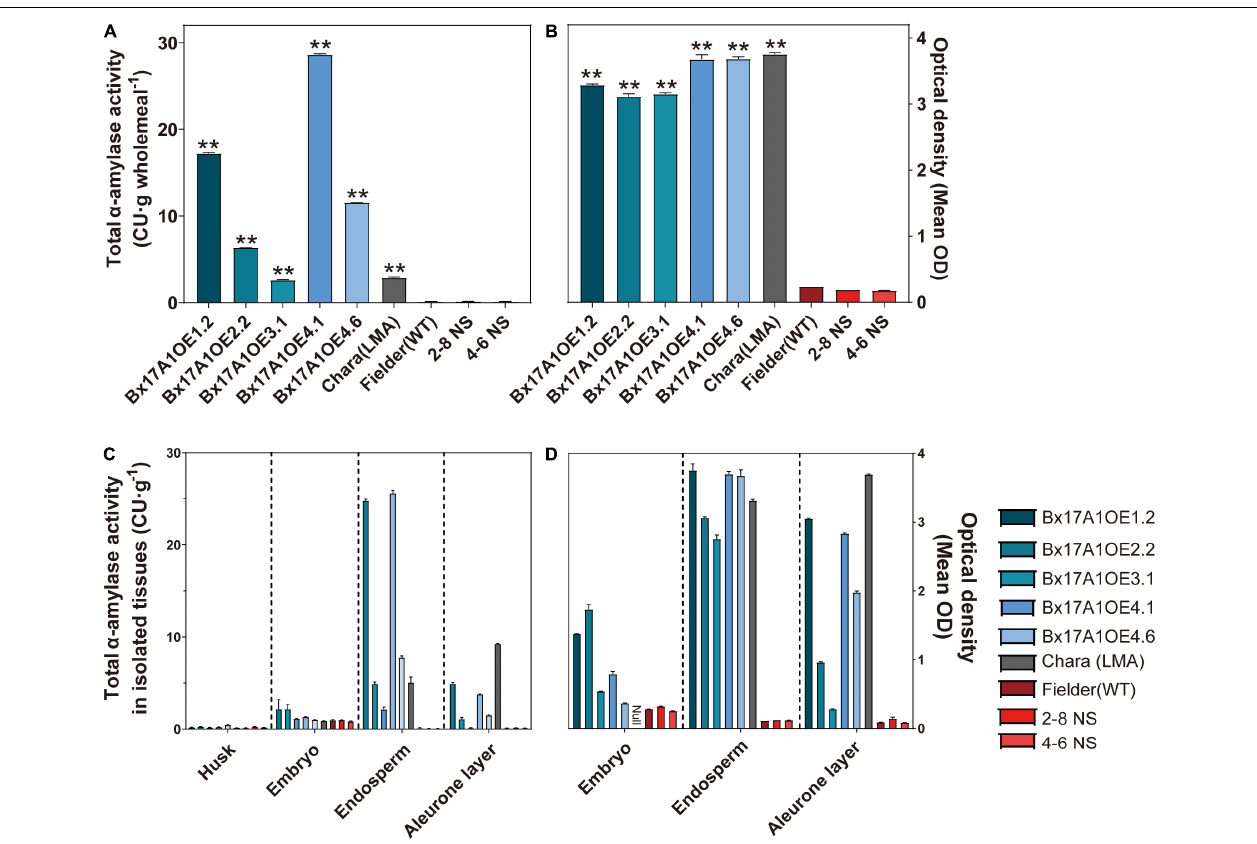
FIGURE 1 | Total α -amylase activity and late maturity alpha-amylase (LMA)-ELISA test in wholemeal flour and TaAMY1 tissue location. (A) Total α -amylase activity is expressed in Ceralpha Units (CU) of per gramme wholemeal. (B) TaAMY1 protein presence in wholemeal flour is expressed by optical density (OD) per 5 mg wholemeal. Total α -amylase activity (C) and TaAMY1 protein (D) in isolated embryo, endosperm, and aleurone layer. Three technical replicates were performed with spherical equivalent (SE) displayed. Bx17A1OE lines were displayed as blue, Chara (LMA) was displayed as grey, and negative controls were displayed as red. p -values are indicated as follows ** p <